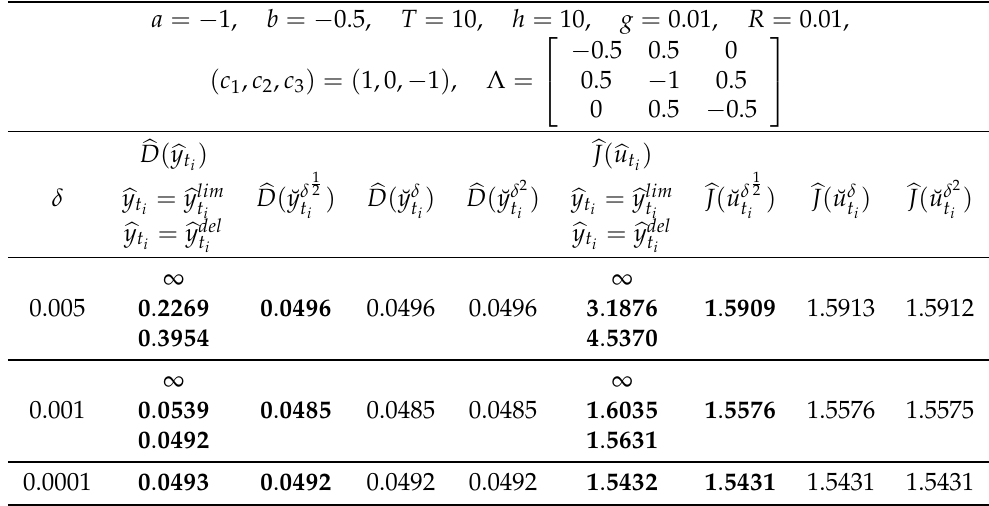
Table 1. The results of the first numerical